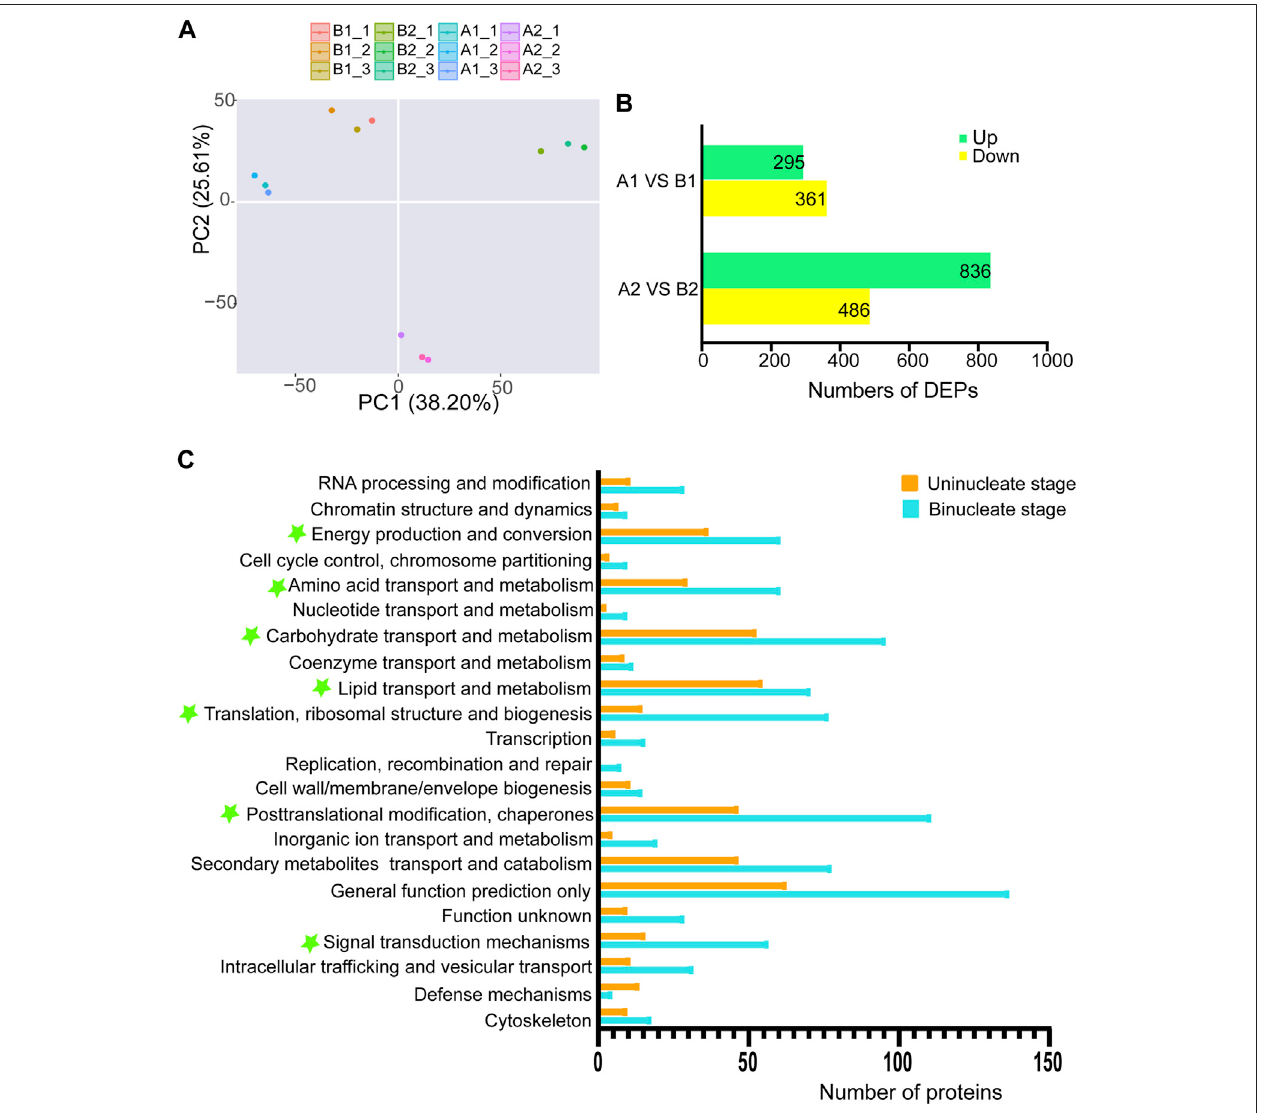
FIGURE 3 | Differentially expressed proteins (DEPs) and functional classi fi cation of DEPs from anther proteome between AL18A and AL18B. (A) Principal component analysis of proteomic data for two stages of wheat anther development. (B) The number of DEPs between AL18A and AL18B at different anther developmental stages. (C) Functional classi fi cation of DEPs at two stages of anther development. All proteins aligned with the KOG database were divided into 24 clusters.